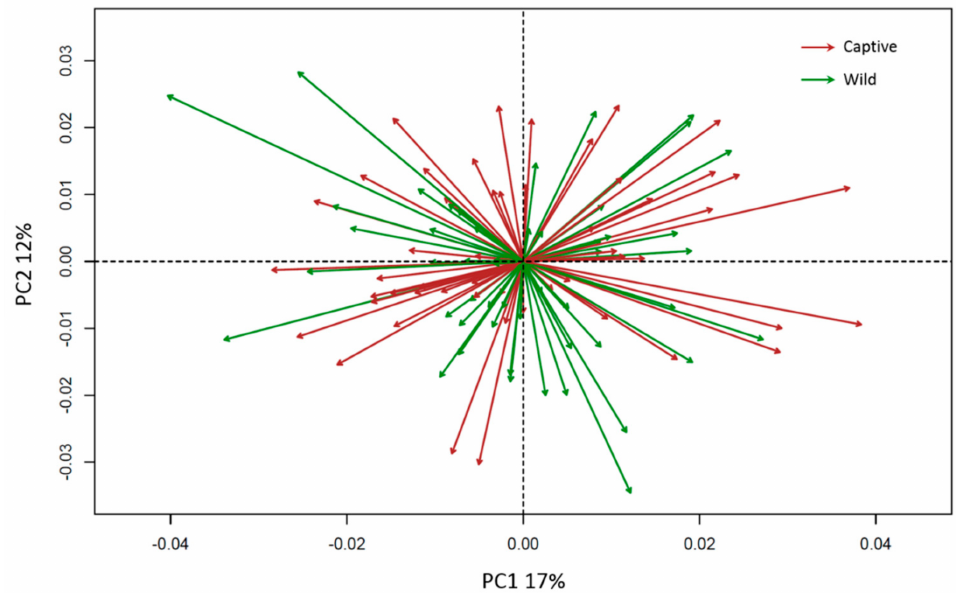
Figure 4. PCA showing the asymmetric vectors of variation departing from the origin (perfect symmetry). The colours indicate the group: green for wild, brown for captive; PC1 and PC2 explain 17% and 12% of total variance,